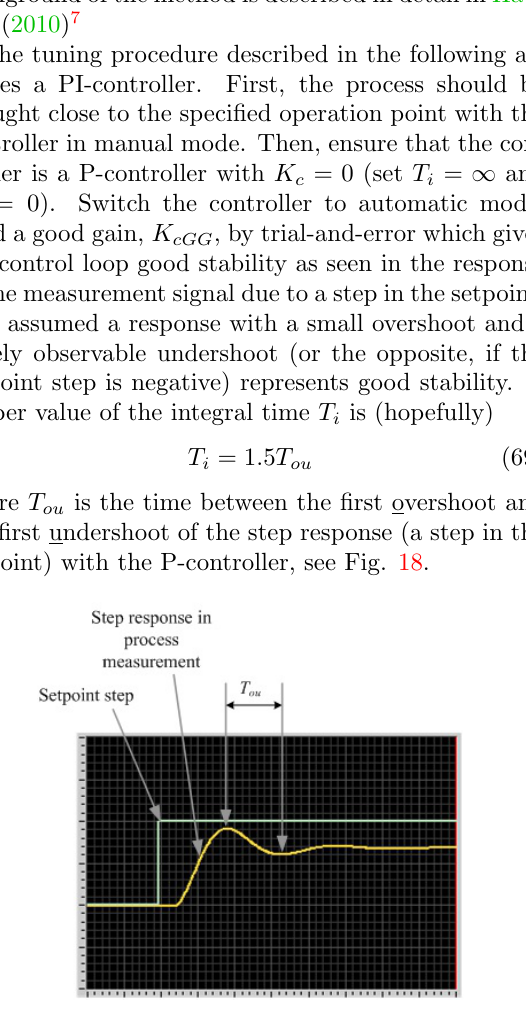
Figure 18: Reading off the time between the first over- shoot and the first undershoot of the step response with P